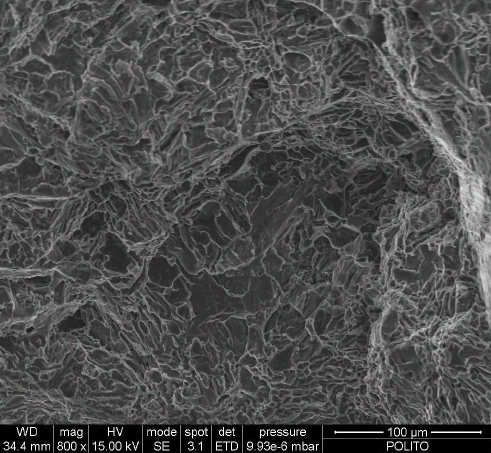
Figura 9: Particolare di una superficie di rottura a fatica in una lega AlSi7Mg-T6. Figure 9: Detail of a fatigue rupture surface in an AlSi7Mg-T6 alloy.